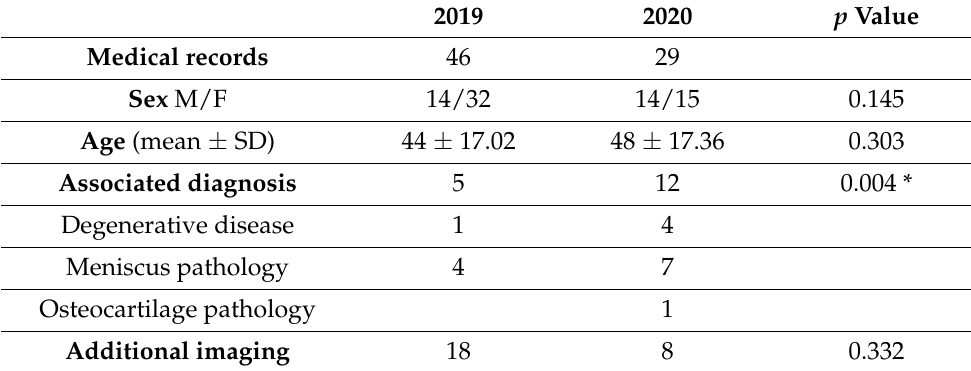
Table 2. Characteristics of patients who underwent knee medical examination (first visits), who were diagnosed with patellofemoral disorders (group 5). Comparison of patients who were diagnosed with patellofemoral disorders in 2019 and 2020. Physical therapy as follow: (1) magneto therapy, (2) tecar therapy, (3) magneto therapy + tecar therapy. Fisher’s exact test was used to assess the differences between groups in terms of categorical variables, unpaired t tests were applied for numerical ones. The table shows the p value of the test. * p < 0.05 for the 2019 vs. 2020